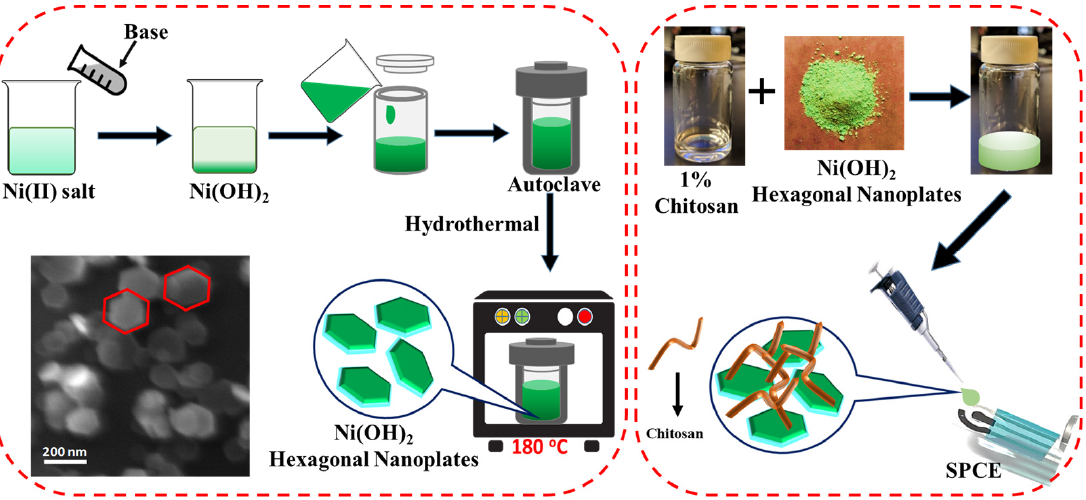
Figure 1. Schematic representation of hydrothermal synthesis process of the Ni(OH) 2 hexagonal nanoplates and the NH ‐ HNP ‐ Chit ‐ modified SPCE fabrication.